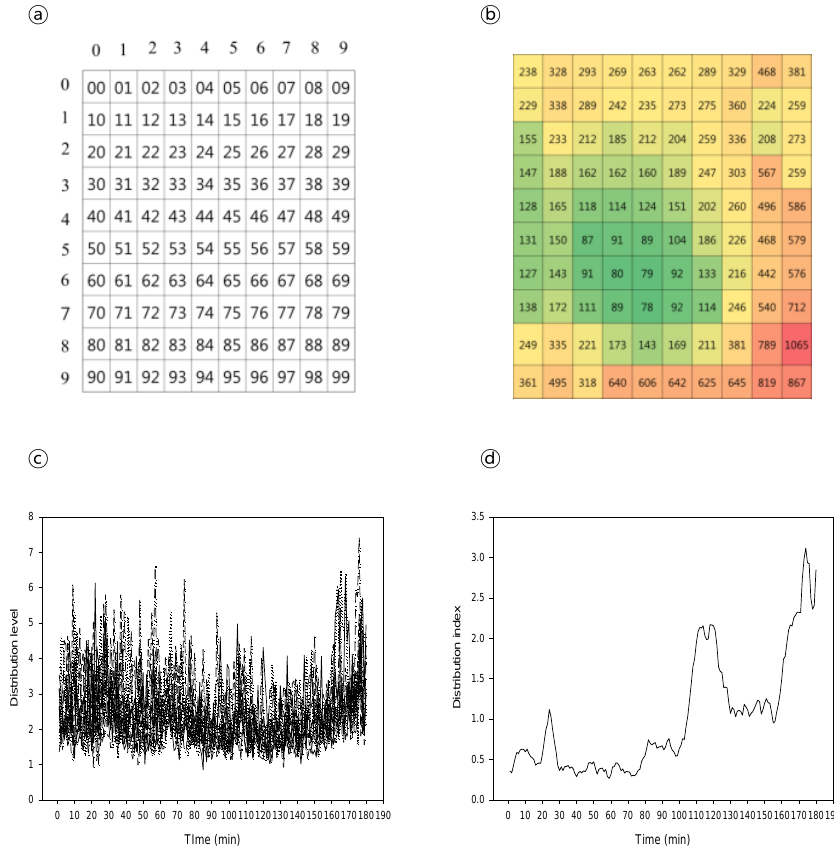
Figure 1. Procedure for generating the distribution index. (a) Numbering sections 00 to 99 for recognition of each section. (b) Calculation of appearance frequency of Daphnia magna at each section; this image was colored to easily view the frequency level of occupation. (Red: highest, Yellow: medium, Green: lowest). (c) Plots of 10 distribution levels derived from 10 Daphnia magna . (d) A Plot of a DI derived from 10 distribution